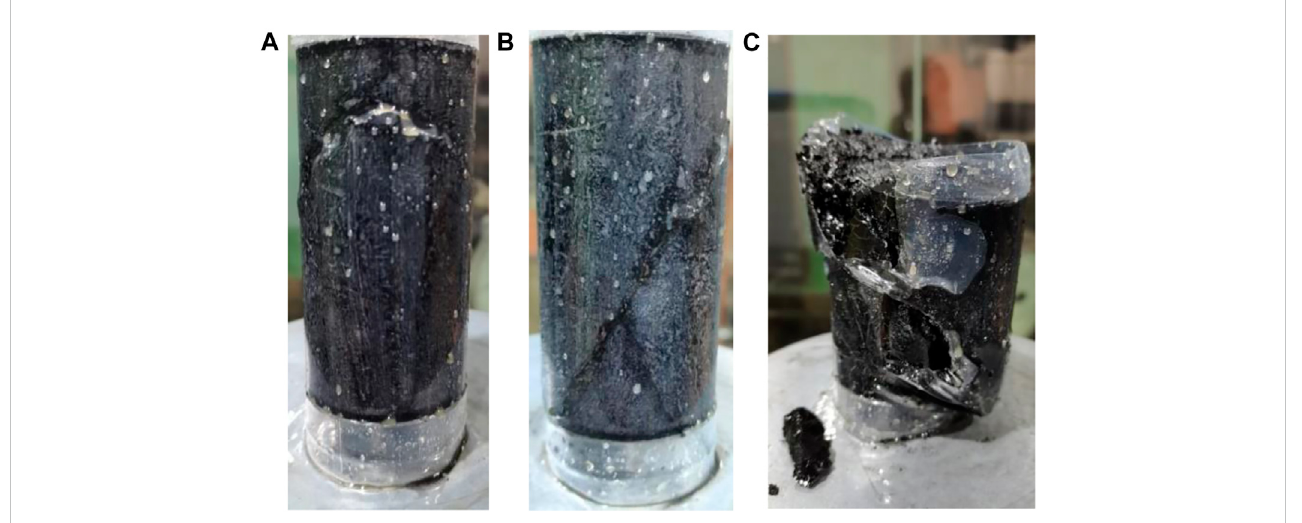
FIGURE 10 Failure modes of coal specimens (A) under not unloading, (B) under 3 MPa amplitude unloading condition, and (C) under 6 MPa amplitude unloading condition.